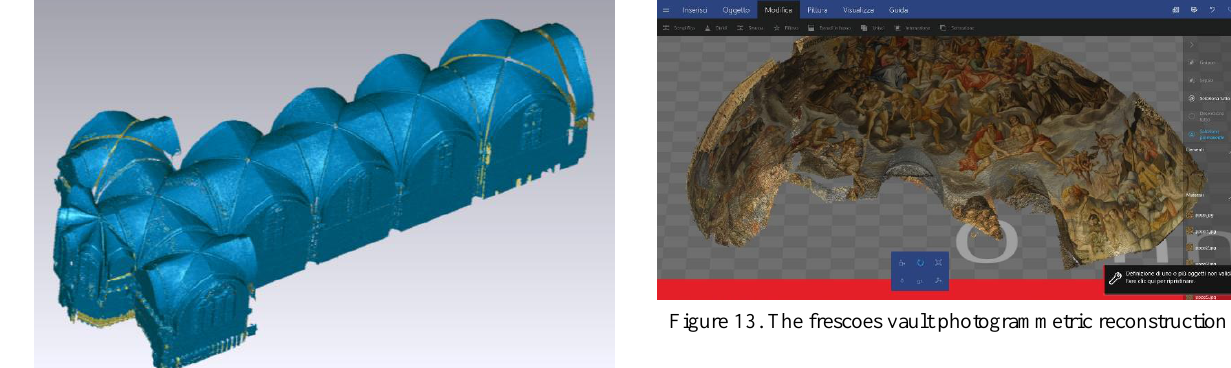
Figure 10. Meshing upper basilica